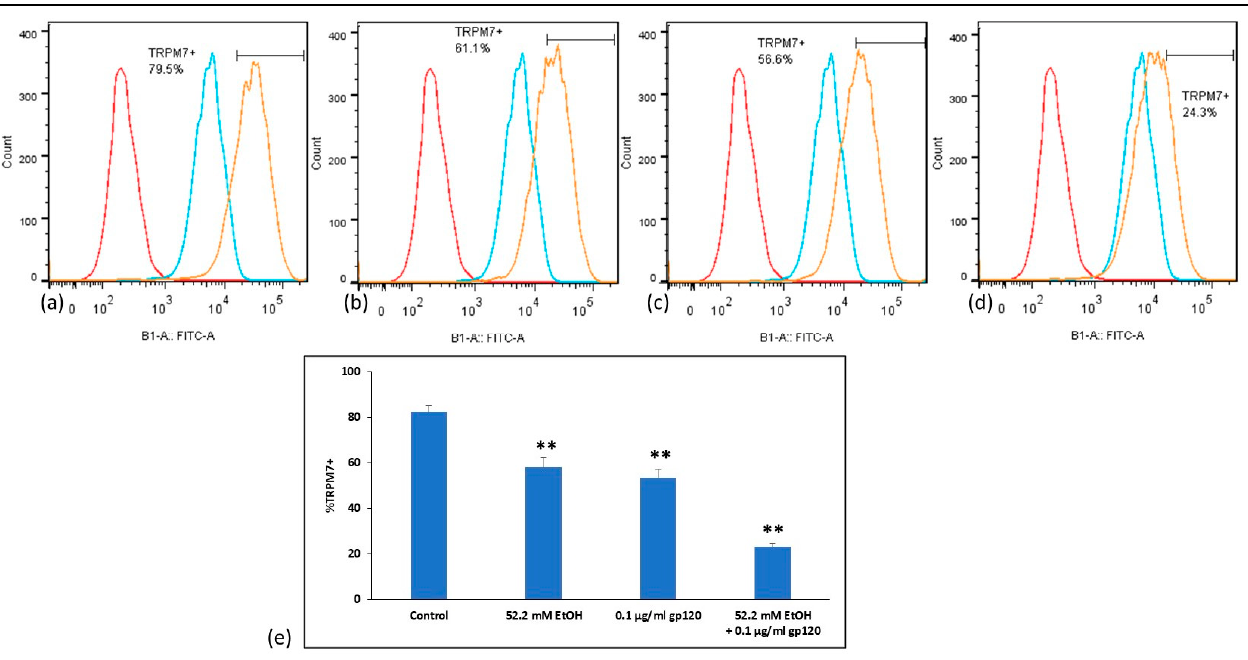
Figure 5. Flow cytometry analysis of TRPM7 expression in human BMVECs: ( a – d ) Representative histograms of intracellular TRPM7. Human BMVECs were stained with primary TRPM7 Ab (orange), isotype control (blue), or unstained (red); ( e ) Human BMVECs treated with 52.2 mM EtOH, HIV-1 gp120, and combination treatment of 52.2 mM EtOH plus gp120 for 24 h. Cells were stained for TRPM7 expression. ** p < 0.01.